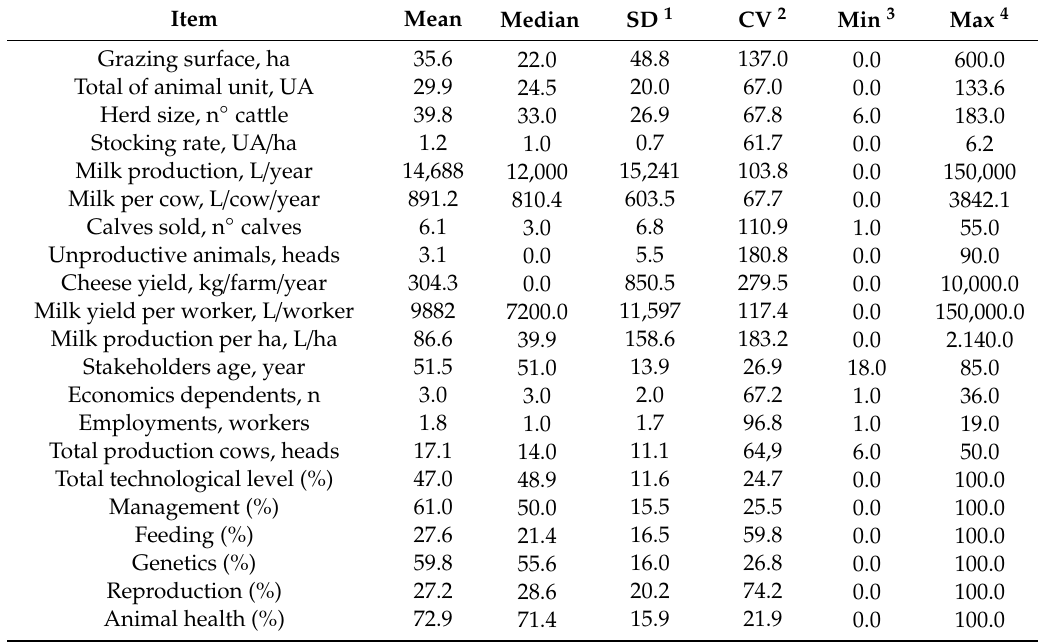
Table 2. Structural and technological characteristics of smallholder dual-purpose farms (n =